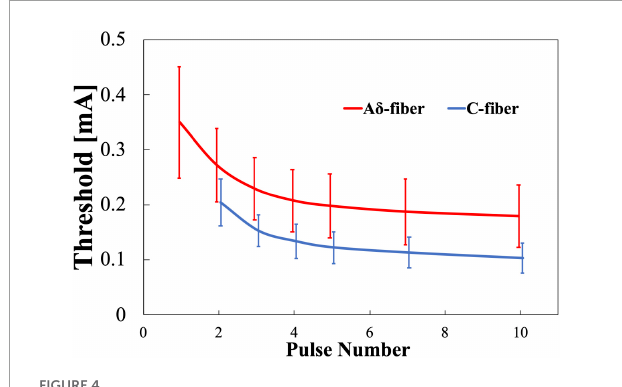
FIGURE4 Experimental pain threshold (mean value and standard deviation, n = 8). Variation with pulse number in A δ - and C-fibers. Note that there was no detection of C-fiber activation at single-pulse stimulation.